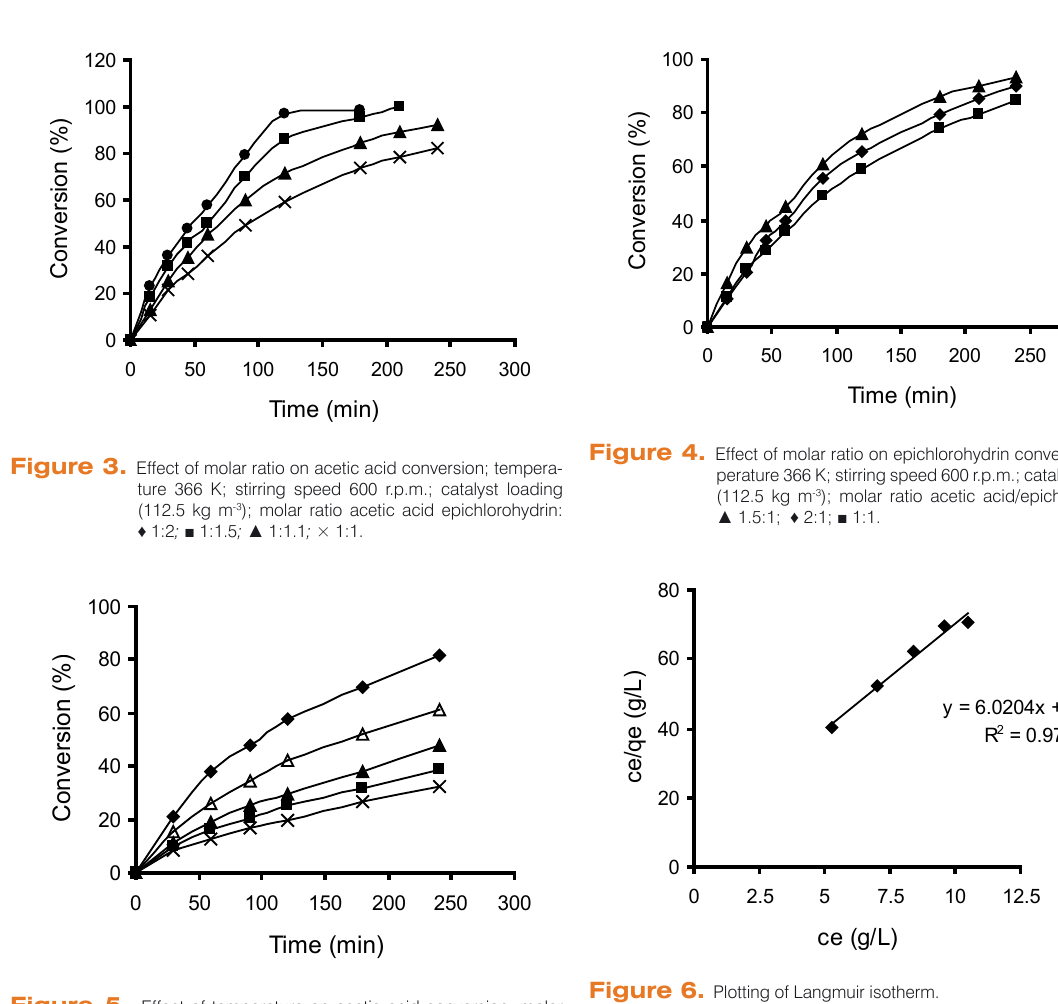
Figure 5. Effect of temperature on acetic acid conversion; molar ratio acetic acid – epichlorohydrin 1:1; stirring speed 600 r.p.m.; catalyst loading (112.5 kg m -3 ): temperature: × 343K; ■ 348K; ▲ 353K; ∆ 358K; ♦ 366K.